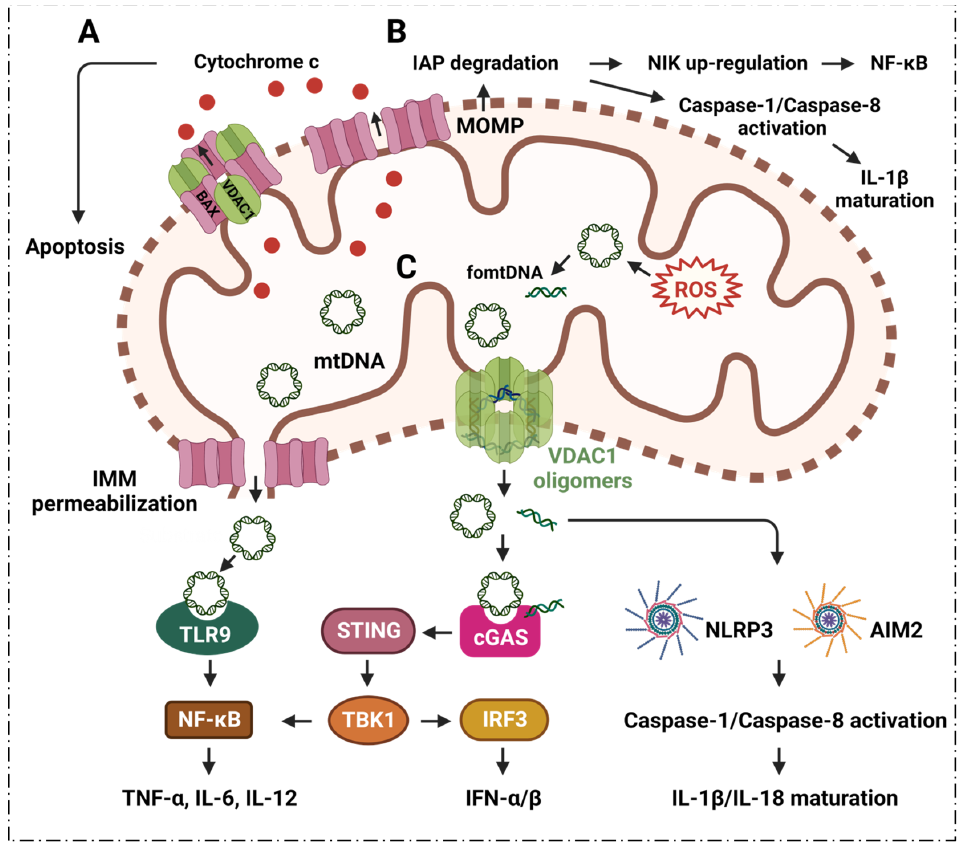
Figure 2. VDAC1 mediates apoptosis and mtDNA release to promote cytokines expression and inflammatory pathogenesis. ( A ) Bcl-2 family member, BAX, interacts with VDAC1 to release cyto- chrome c into the cytoplasm, promoting apoptosis. ( B ) MOMP induces proteasomal degradation of IAPs, which causes NIK to further induce the pro-inflammatory NF- κ B signal and activate caspase- 1/8; this in turn results in the maturation of pro-inflammatory factor IL-1 β . ( C ) Mitochondrial over- produced ROS oxidize mtDNA to fomtDNA. The mtDNA and fomtDNA pass the VDAC1 oligomers channel or the oligomerization BAX pore into the cytoplasm. The released mtDNA/fomtDNA induce the cGAS-STING pathway to promote interferon gene expressions via TBK1-IRF3 to up-regulate IFN- α / β , or through TBK1-NF- κ B to enhance TNF- α , IL-6 and IL-12. Additionally, mtDNA interacts with TLR9 and promotes TNF- α , IL-6 and IL-12 expression via NF- κ B signaling. Moreover, the released mtDNA induces the NLRP3 inflammasome and AIM2 inflammasome to enhance caspase-1/8 activation to promote IL-1 β /IL-18 maturation. Abbreviations: AIM2: absent in melanoma 2; BAX: Bcl-2-associated X protein; cGAS: cyclic GMP-AMP synthase; Cyto c: cytochrome c; fomtDNA: oxidized mtDNA fragments; IAP: inhibitors of apoptosis; IFN: interferon; IL: interleukin; IRF3: interferon regulatory factor 3; IMM: inner mitochondrial membrane; MOMP: mitochondrial outer membrane permeabilization; mtDNA: mitochondrial DNA; NF- κ B: nuclear factor- κ B; NIK: NF- κ B induced kinase; NLRP3: nucleotide-binding domain and leucine-rich repeat (LRR) containing P3; ROS: reactive oxygen species; STING: stimulator of interferon genes; TLR9: Toll-like receptor 9; TBK1: TANK-binding kinase 1; TNF: tumor necrosis factor; VDAC1: voltage-dependent anion channel 1. Apoptosis may cause mitochondrial outer membrane permeabilization (MOMP), which further induces inflammatory responses via multiple pathways [62] (Figure 2). The The cGAS-STING pathway mediates the escape of mtDNA from stressed mitochon- outer mitochondrial membrane pore gradually enlarges after MOMP, further causing ex- dria, provoking inflammation and further leading to calcium uptake and the trusion and rupture of the inner mitochondrial membrane (IMM); this leads to the release of mitochondrial DNA (mtDNA) into the cytoplasm [62] (Figure 2). The cytoplasmic mtDNA, together with cyclic GMP-AMP synthase (cGAS)-stimulator of interferon genes